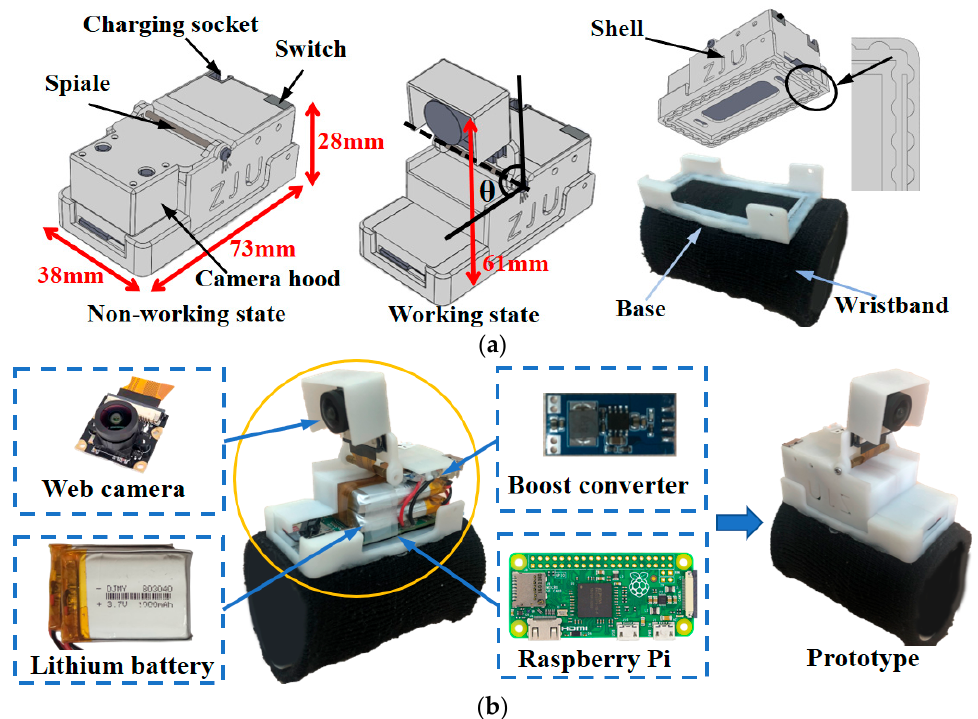
Figure 2. ( a ) Concept design of the wearable wrist-worn camera with an emphasis on wearability and user’s comfort; ( b ) Integrated implementation of the wearable wrist-worn